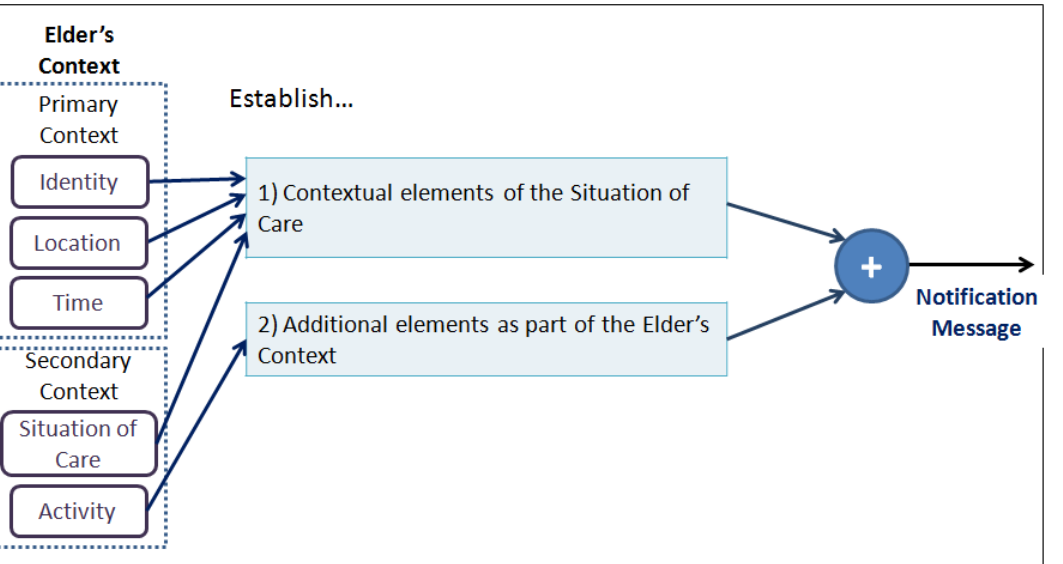
Figure 2. Model for the Composition of the Notification Message.